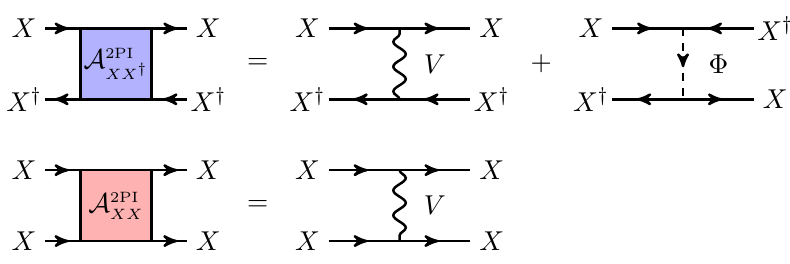
Figure 1 . The 2PI diagrams contributing to the non-relativistic potential for XX y pairs (upper) and XX or X y X y pairs (lower). The arrows denote the (cid:13)ow of the U(1) D